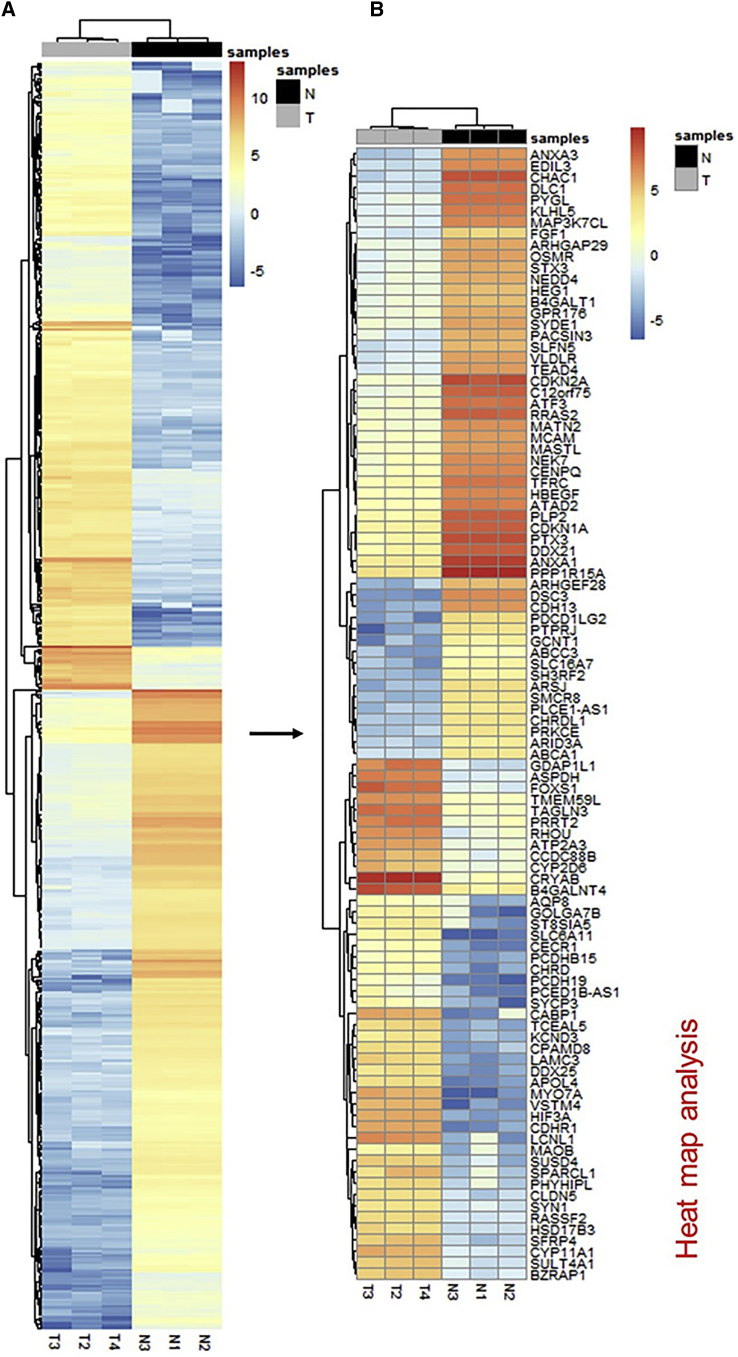
Analysis of the Differentially Expressed Genes in MB Patient Tissue(A) A heatmap of 675 differentially expressed genes; (B) a heatmap of selected 100 differentially expressed genes and their log-normalized expression in normal (N; black) and MB (T; gray) samples were drawn. Red represents upregulation, and blue represents downregulation.